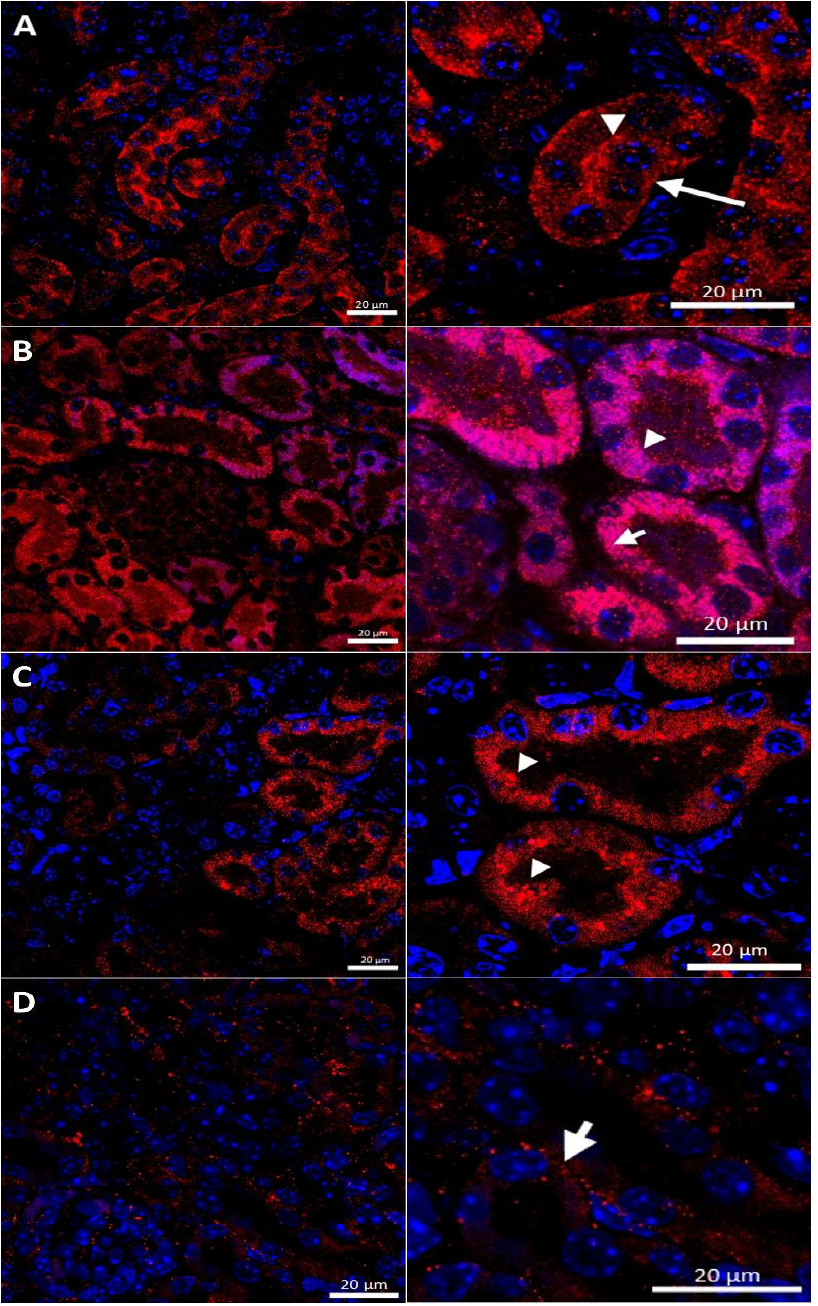
Figure 3. Immunofluorescent staining of the CTR1 protein (red, channel) analyzed by confocal microscopy in the kidney of the suckling (14-day-old). Right panels show digital enlargement of CTR1 staining visualized in left panels to reveal details of CTR1 cellular localization. This was performed